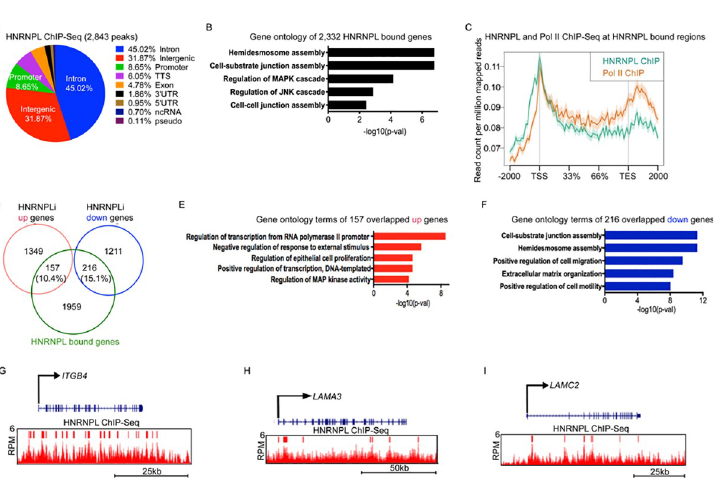
Fig 3. HNRNPL binds to hemidesmosome and cell-substrate assembly genes. (A) Genomic localization of the 2,843 HNRNPL bound peaks. The percent of HNRNPL binding to each genomic region is shown. HNRNPL ChIP-Seq was performed in primary human keratinocytes in growth conditions ( n = 3 independent experiments). (B) GO terms of the 2,332 genes that the 2,843 HNRNPL bound peaks mapped to. (C) Metagene plot of HNRNPL (teal) and RNA Pol II (orange) ChIP-Seq reads at HNRNPL bound regions. Y-axis is shown as read count per million reads, and X-axis is the distance along HNRNPL bound genes. TSS is transcription start site, and TES is transcription end site. (D) Venn diagram of HNRNPL bound genes (HNRNPL ChIP-Seq) with genes up-regulated or down-regulated upon HNRNPL depletion. (E) GO terms of the HNRNPL bound genes that overlap with genes increased upon HNRNPL loss. (F) GO terms of the 216 decreased genes upon HNRNPL knockdown that overlap with HNRNPL bound genes. (G–I) Gene tracks of ITGB4 (G), LAMA3 (H), and LAMC2 (I). HNRNPL ChIP-Seq is shown in red. Y-axis shows RPM, and red bar over gene tracks represent significant peaks. X-axis shows position along gene. Primary data for this figure can be found in S1 Data. ChIP-Seq, chromatin immunoprecipitation sequencing; GO, gene ontology; HNRNPL, heterogeneous nuclear ribonucleoprotein L; Pol II, polymerase II; RPM, reads per